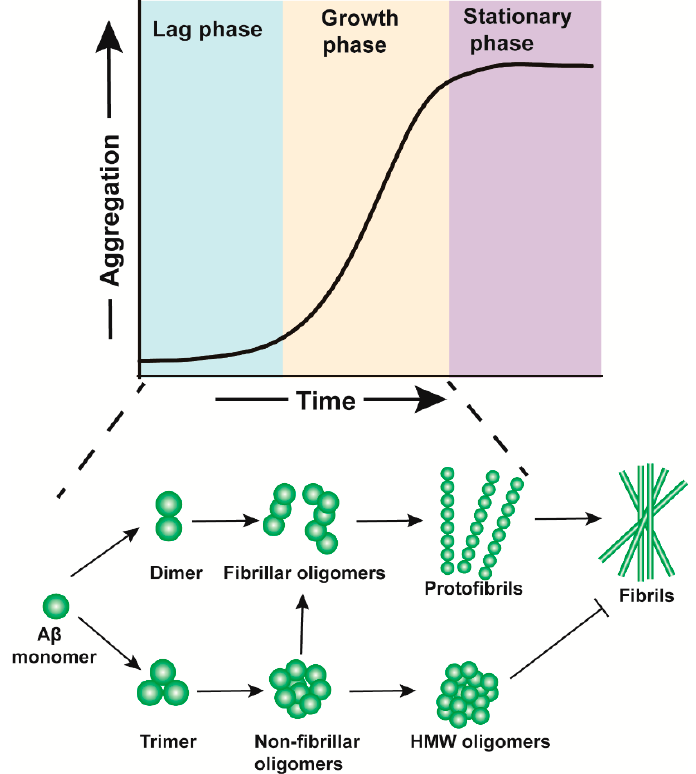
Figure 1. Schematic representation of the process of β -amyloid (A β ) aggregation. There are three phases from A β monomers to mature fibrils: an initial lag phase, a subsequent growth phase and a final stationary phase. β -amyloid oligomers (A β os), necessary intermediates in fibril generation, mainly exist in lag phase and growth phase. Some A β os, termed as fibrillar oligomers, can quickly form protofibrils and mature fibrils through fibril-forming pathway, in which the first step corresponds to the formation of A β dimers, whereas others such as A β trimers or globulomers, termed as non-fibrillar oligomers, are structurally distinct from fibrillar aggregates, and they contribute to the formation of fibrils through a structural conversion to become fibrillar oligomers.